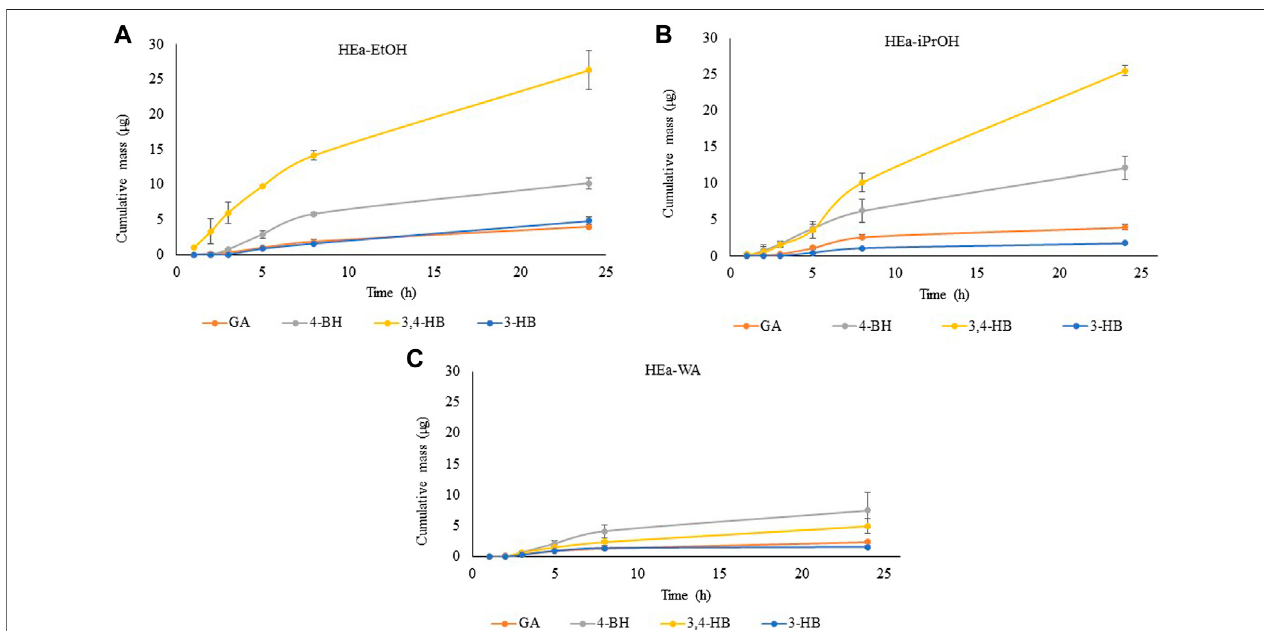
FIGURE6| Time course ofthecumulative massofphenolic acidsduring the 24 hpermeation. In thedonor chamber placed 1 cm 3 ofHEas; HEa-EtOH — hydrogel containing dry ethanolic extract of E. angustifolium (A) ; HEa-iPrOH — hydrogel containing dry isopropanol extract of E. angustifolium (B) ; HEa-WA — hydrogel containing dry water extract of E. angustifolium (C) ; Values are expressed as mean ± SD ( n = 3).